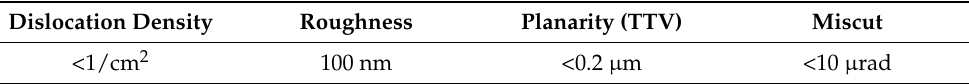
Table 2. Requirements on wafer before shaping of crystal specimen for LHC collimation. Dislocation Density Roughness Planarity